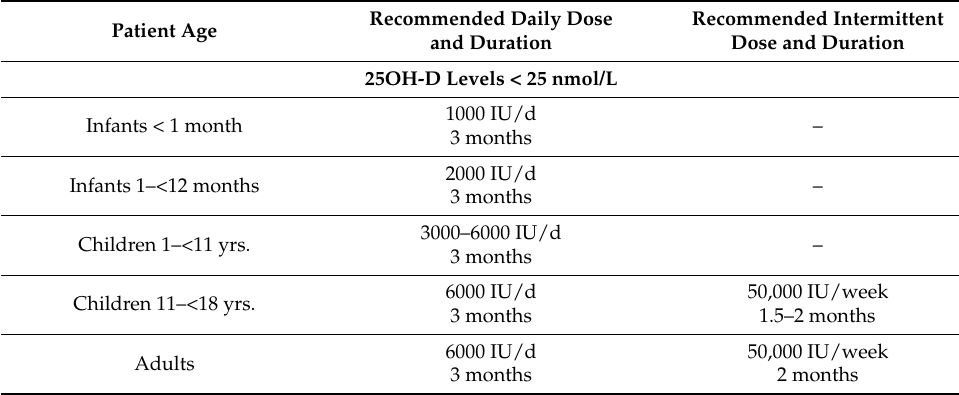
Table 4. Vitamin D therapeutic